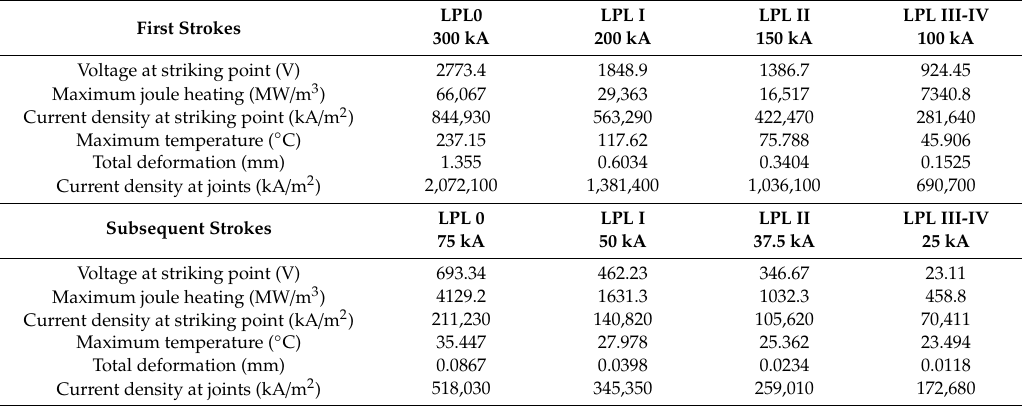
Table 6. Results obtained from the first and subsequent return strokes for Case Study E.